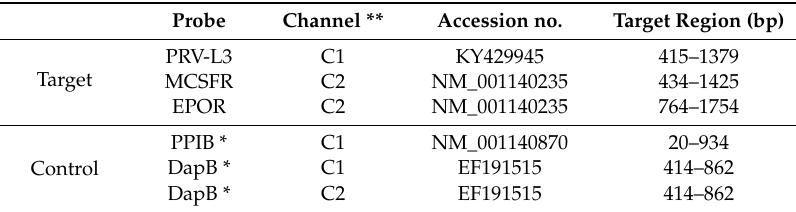
Table 2. Target and control probes for in situ